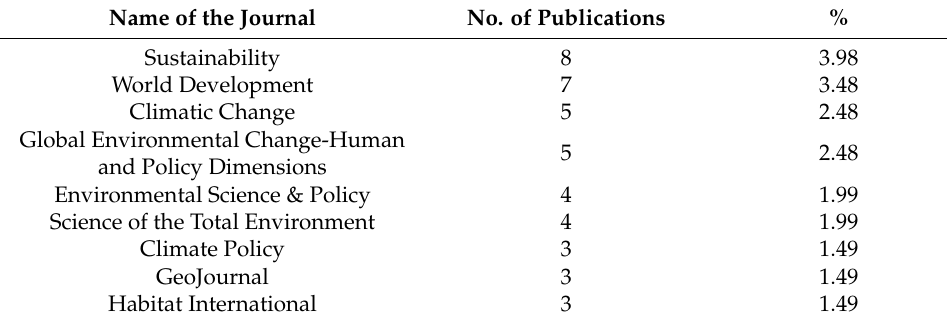
Table 2. Contributions per journal.